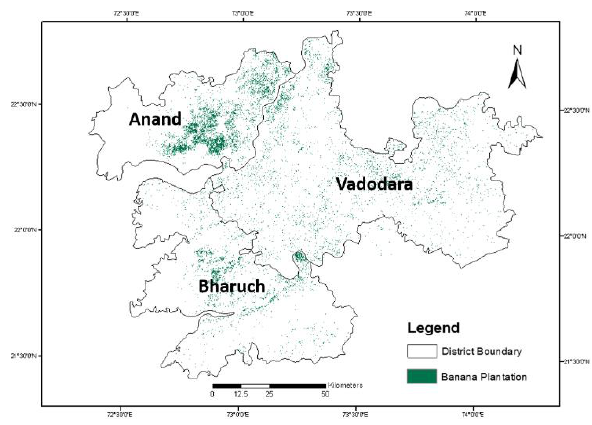
Figure 6. Spatial distribution of banana in Anand, Bharuch and Vadodara districts of